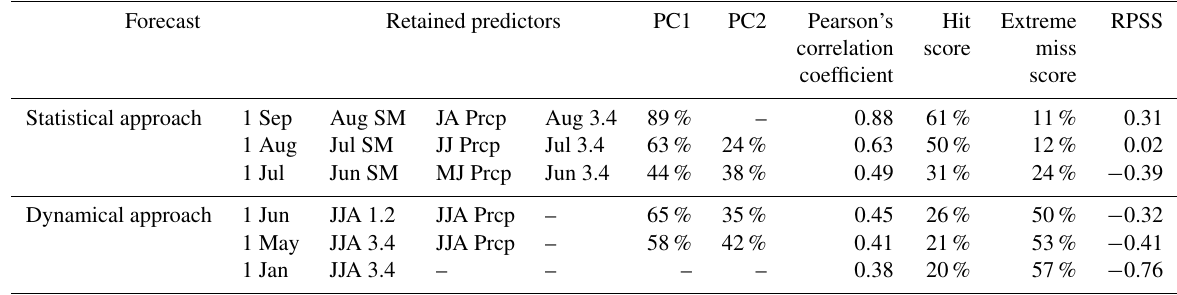
correlation score miss coefficient score